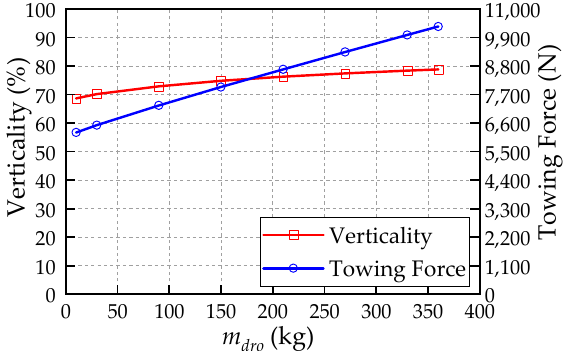
Figure 7. Verticality and towing force vs. drogue mass.